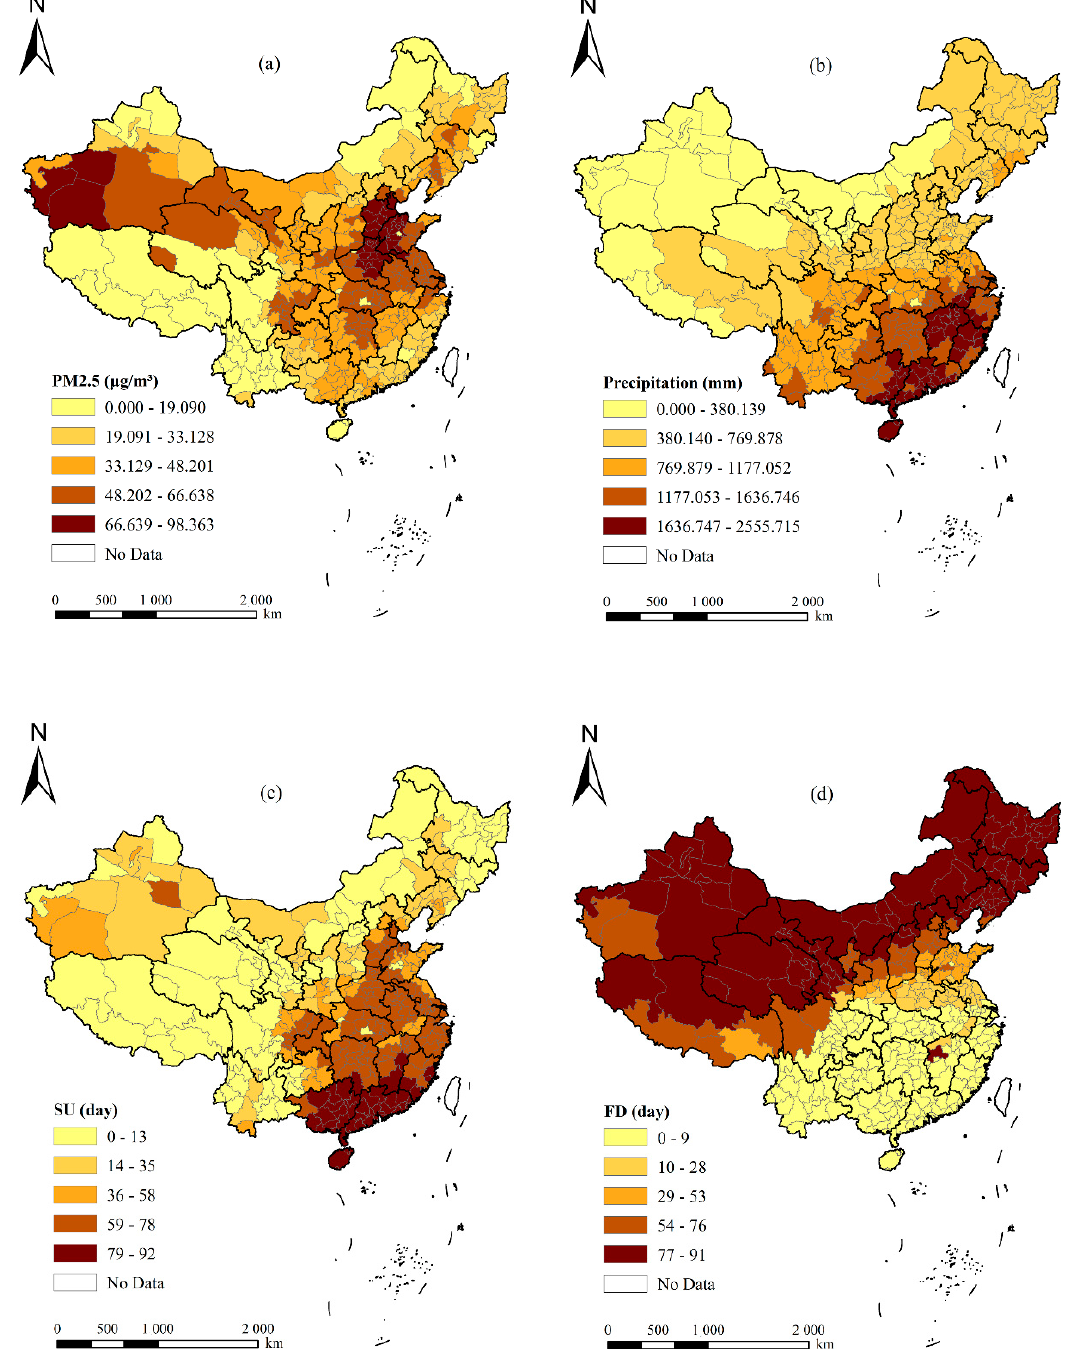
Figure 3. The spatial patterns of PM2.5 ( μ g/m 3 ) ( a ), precipitation (mm) ( b ), number of frost days (day) ( c ), and number of summer days (day) from 2009 to 2017 ( d ).